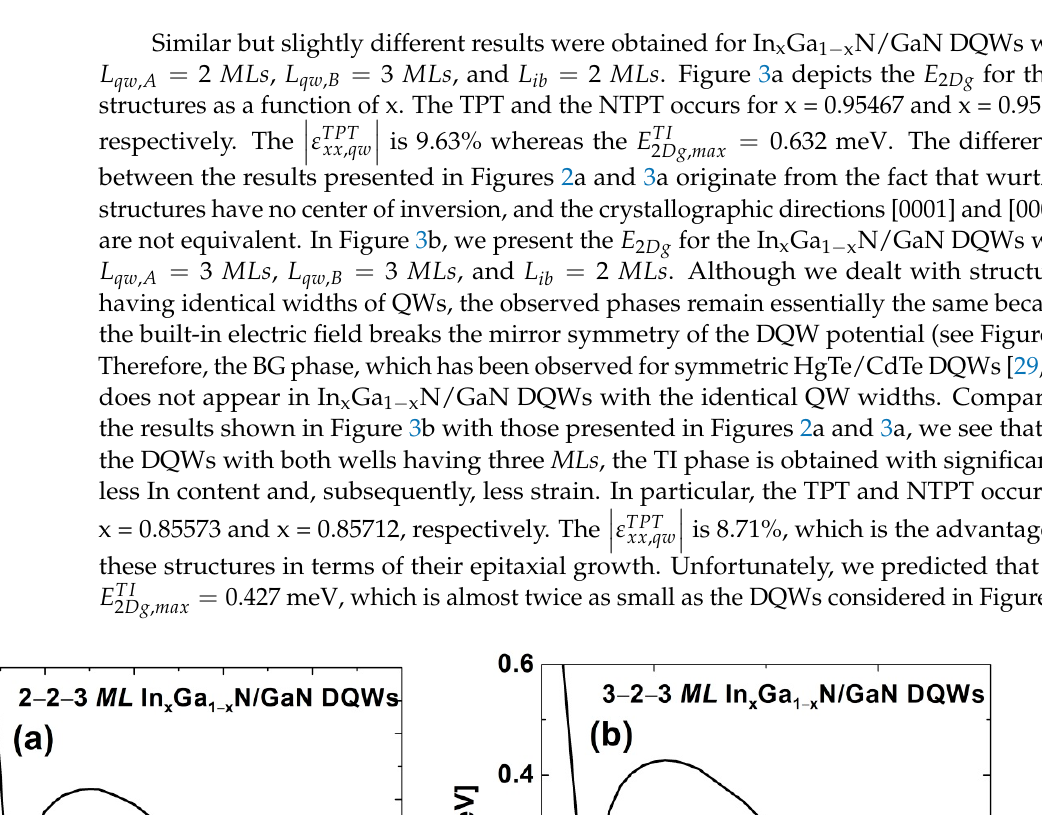
Figure 2. ( a ) The 𝐸 (cid:2870)(cid:3005)(cid:3034) for In x Ga 1 − x N/GaN DQWs with 𝐿 (cid:3044)(cid:3050),(cid:3002) = 3 𝑀𝐿𝑠 , 𝐿 (cid:3044)(cid:3050),(cid:3003) = 2 𝑀𝐿𝑠 , and 𝐿 (cid:3036)(cid:3029) = 2 𝑀𝐿𝑠 as a function of the In content in the QWs. ( b – e ) The sub-band dispersions for ( b ) the NI, ( c ) WSM, ( d ) TI, and ( e ) NTSM occurring in these DQWs.